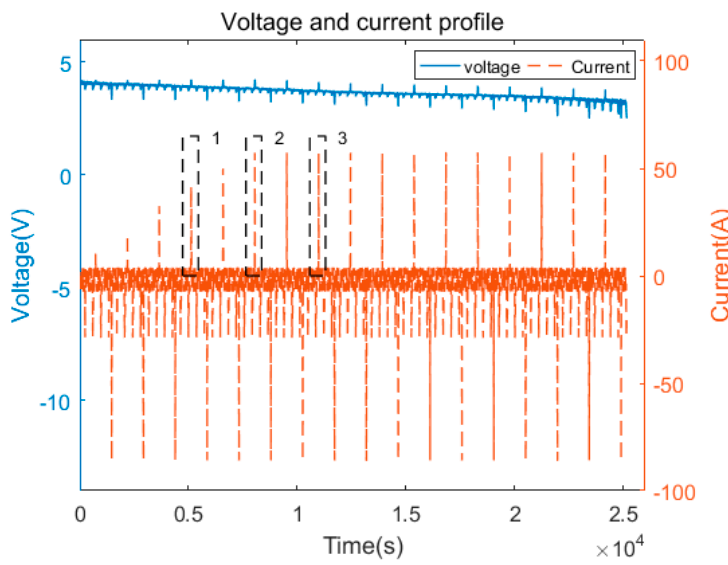
Figure 5. The operational voltage and current profile under the Federal Urban Driving Schedule (SFUDS).